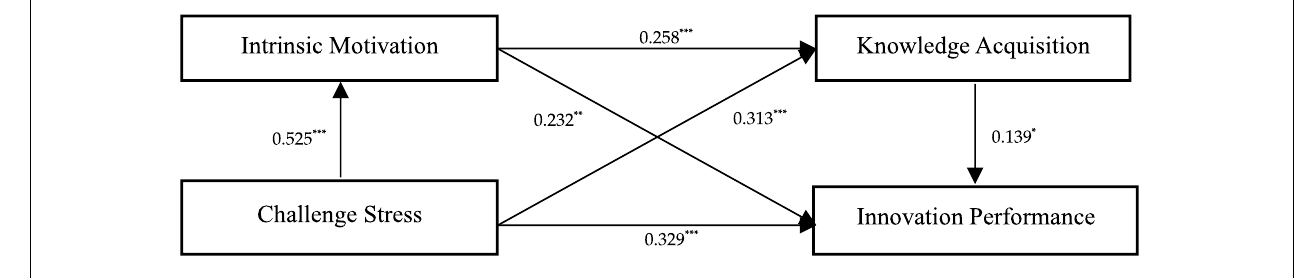
FIGURE 2 | Main effect and indirect effect. n = 376; * p < 0.05; ** p < 0.01; *** p <